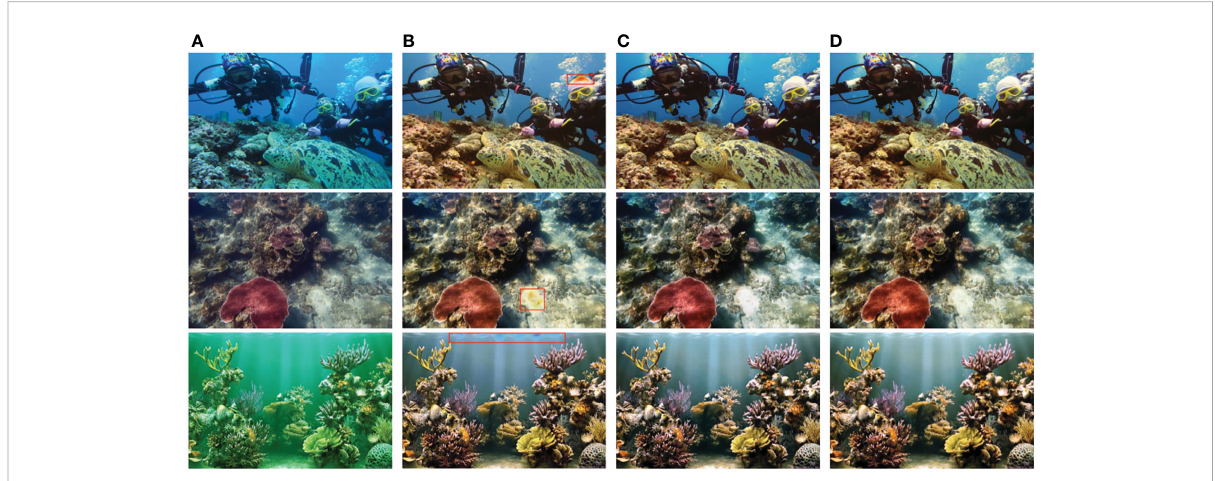
FIGURE 12 Visual comparisons with different network widths C in EDB and EUB on the UIEB dataset. From left to right, (A) shows the raw underwater images, and (B – D) are the results of C = 8, C = 16 and C = 32,